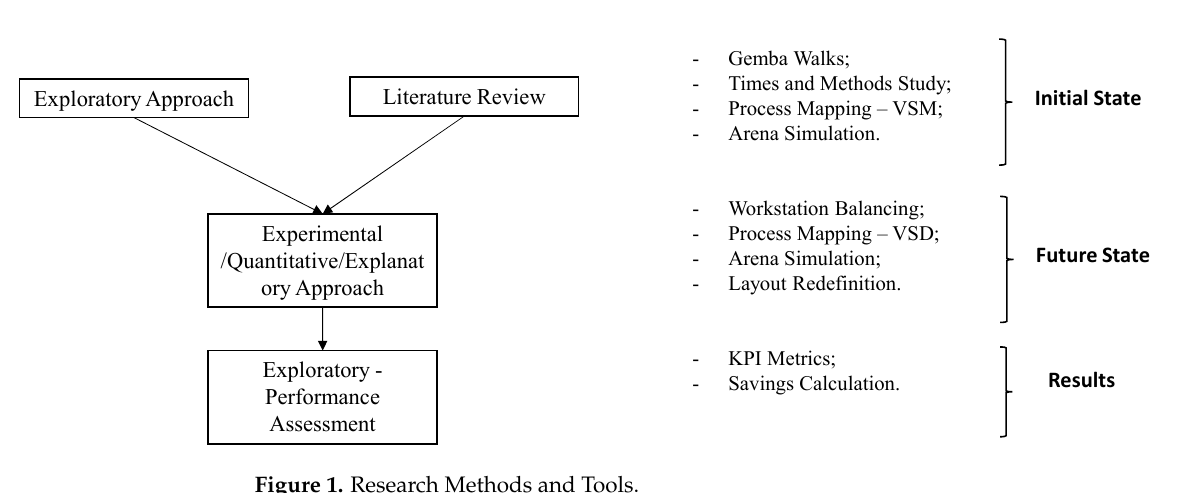
Figure 1. Research Methods and Tools.